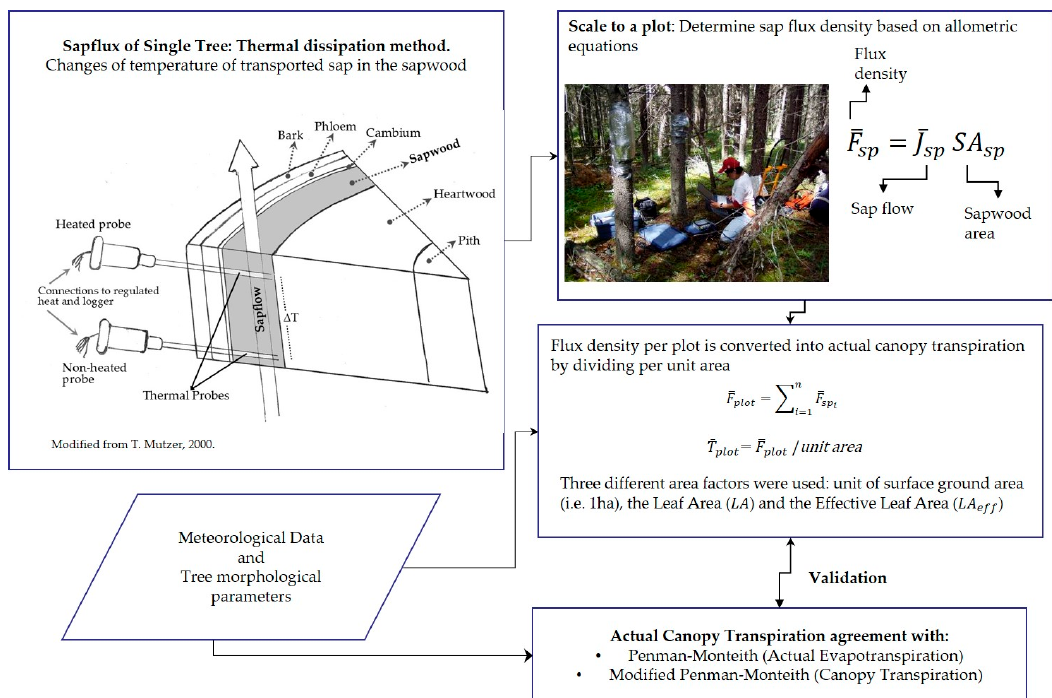
Figure 1. Sap flow measured at a single tree point, can provide actual tree sap flux estimates when